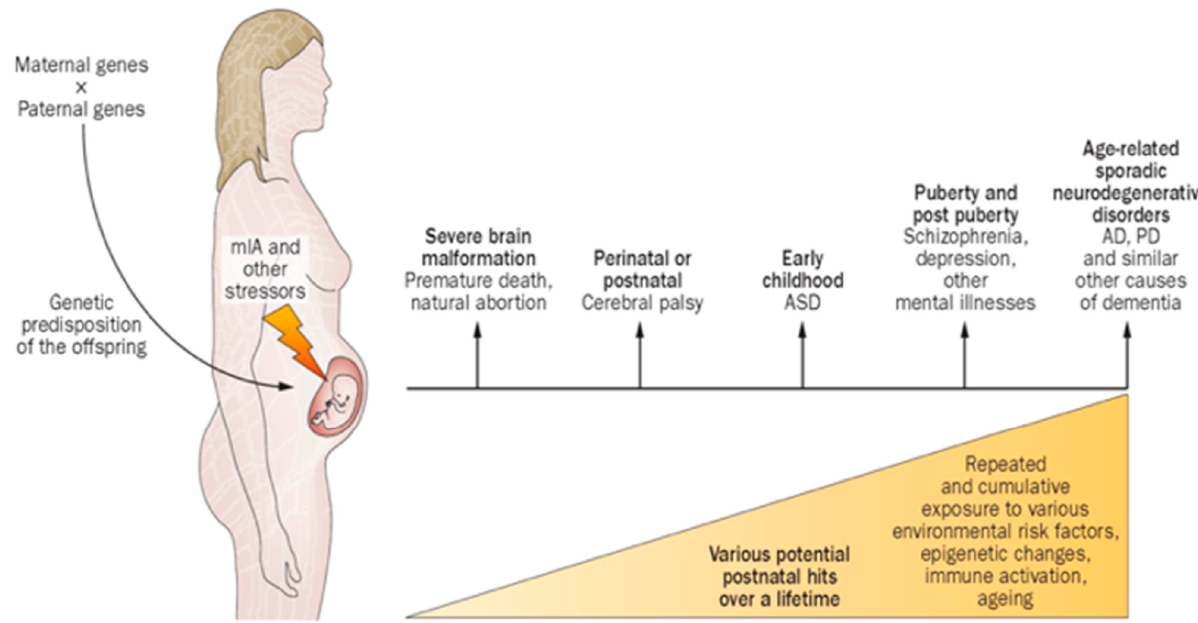
Figure 3. Proposed interrelated factors associated with maternal immune activation in humans, expressed as a spectrum of neurologic/behavioral disorders expressed by the child, juvenile, adult or elderly individuals. Abbreviations: AD, Alzheimer’s disease; ASD, autism spectrum disorder; MIA, maternal immune activation; PD, Parkinson’s disease [36].